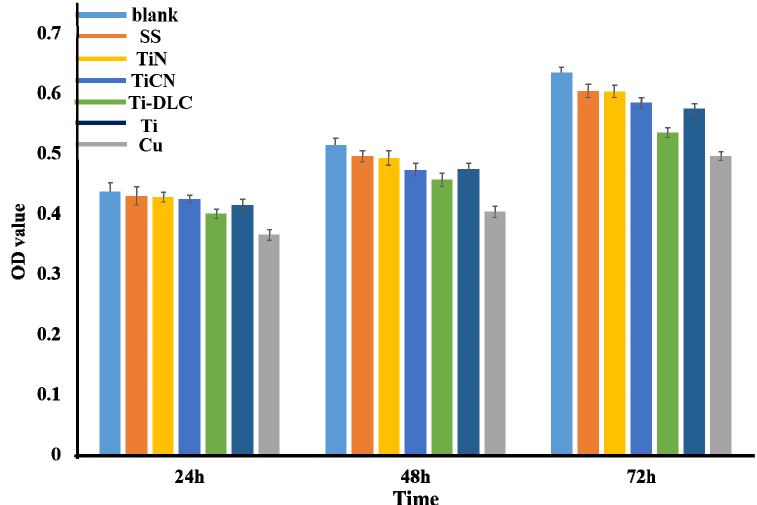
Figure 5. Cell absorbance OD value for the samples after 24, 48, and 72 h of incubation.